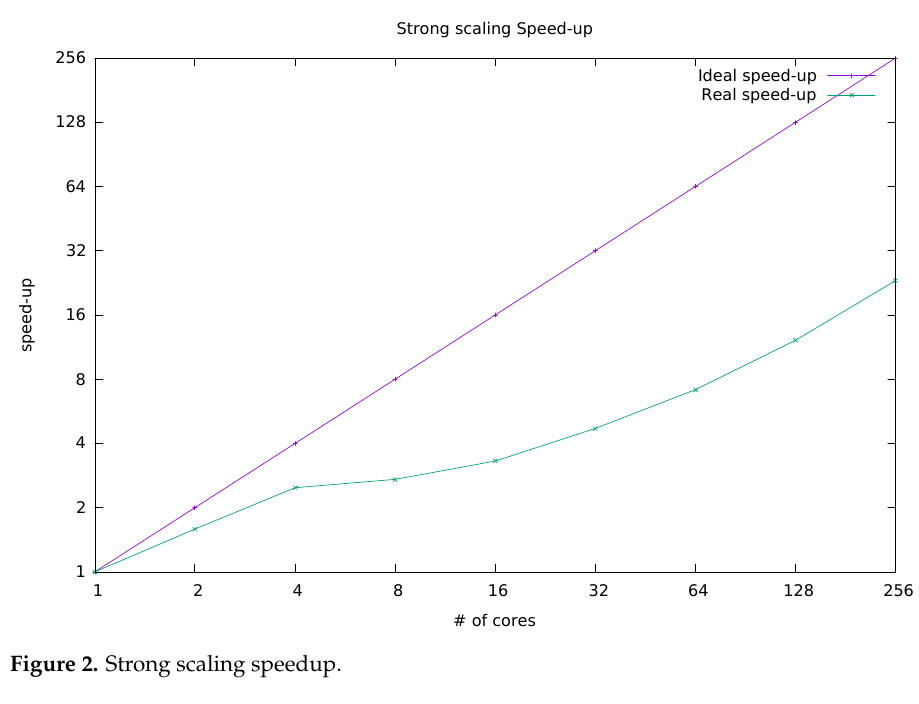
Figure 2. Strong scaling speedup.